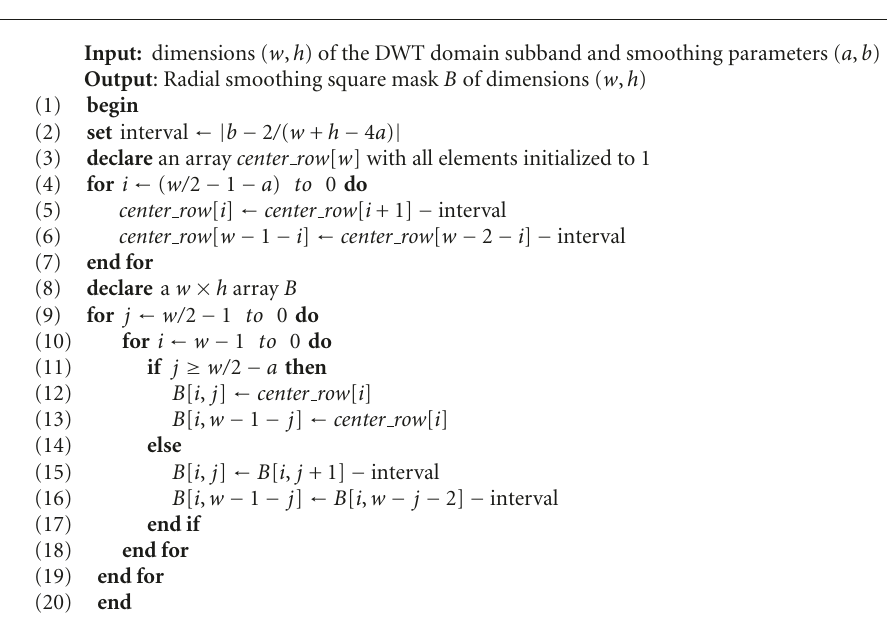
Algorithm 2: Example radial smoothing